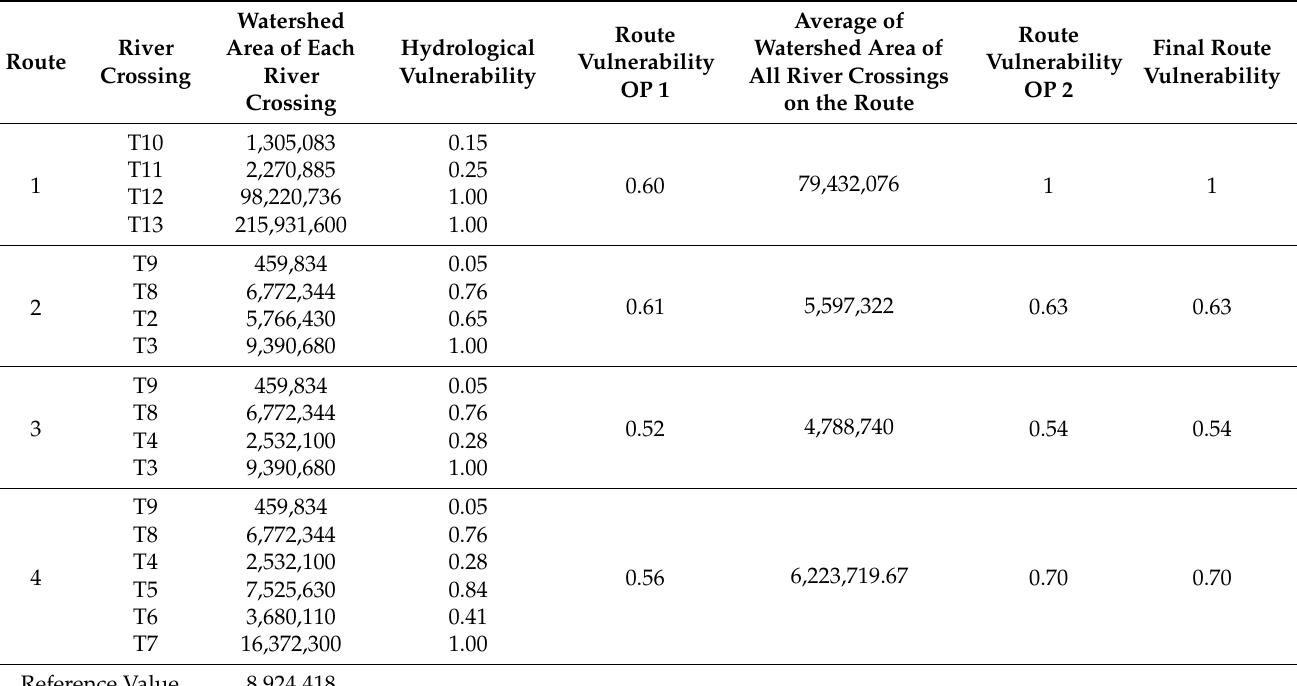
Table 4. Flood vulnerability evaluation of mobility of industrial park